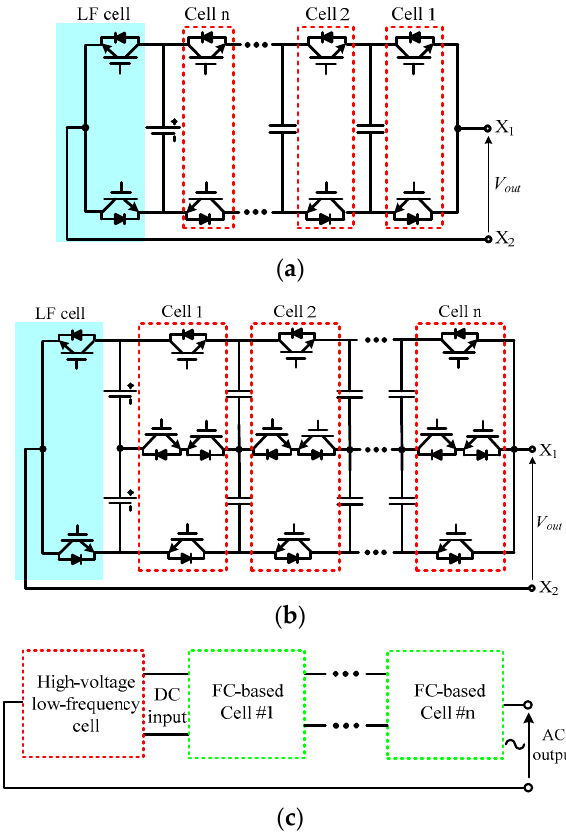
Figure 14. General topologies of hybrid FC ‐ based multicell converters. ( a ) (2n+1) ‐ level double flying capacitor multilevel (DFCM) converter with n FC cells [45], ( b ) (4n+1) ‐ level reduced SM converter with n T ‐ type cells [46], ( c ) general structure with n FC ‐ based cells.